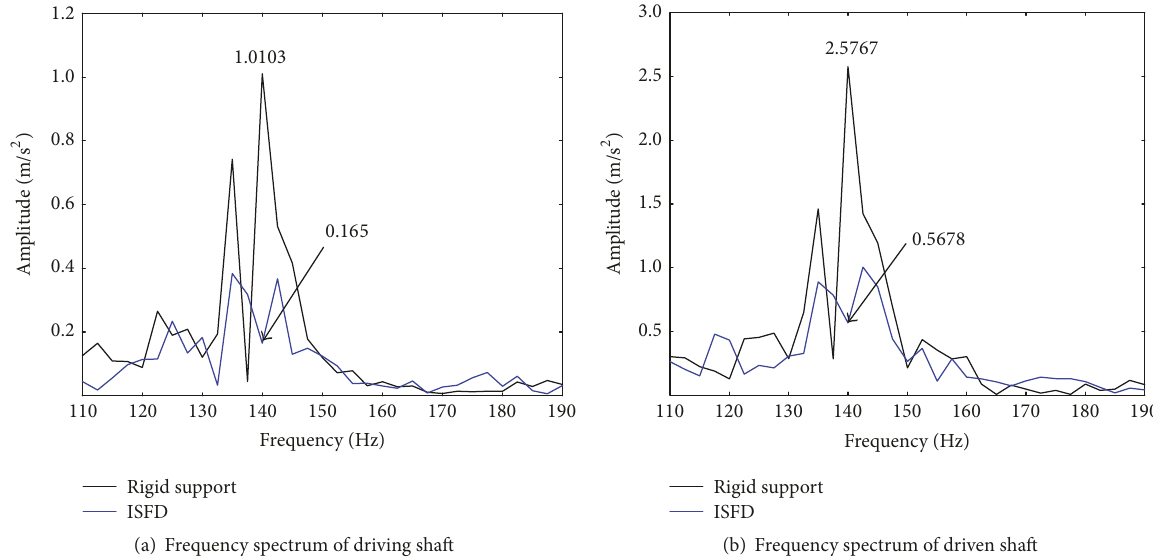
Figure 11: Comparison of data in the range of 110 ∼